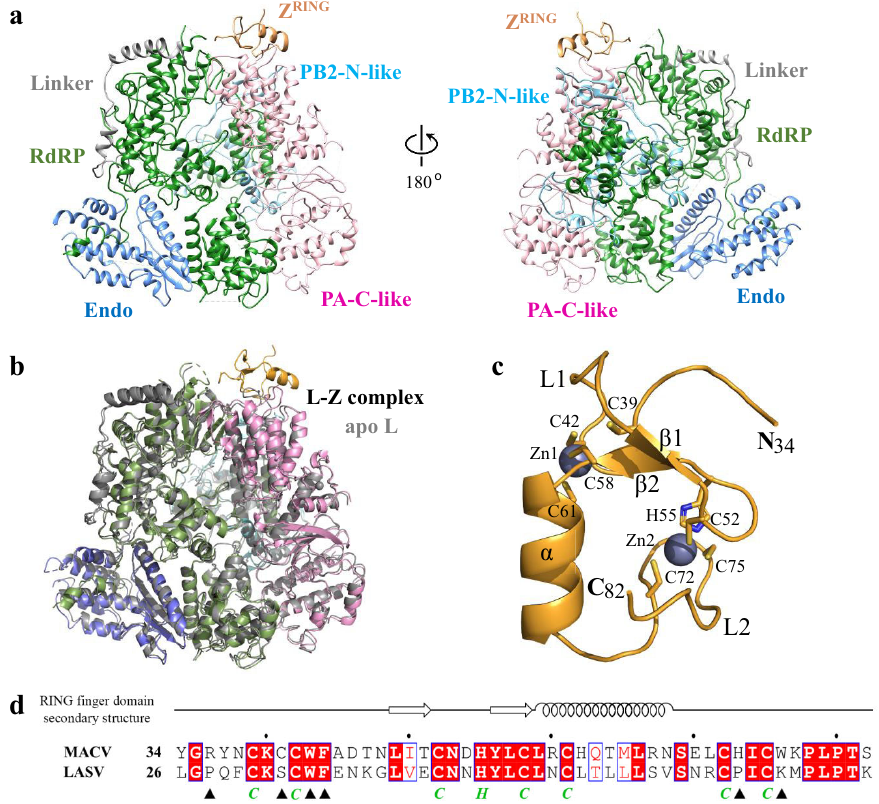
Fig. 2 Structure of the MACV L – Z complex. a Atom model of the L – Z complex shown as ribbon in two orientations. The domains are indicated and colored as in Fig. 1a. b Superposition of MACV L in the states of apo (colored gray) and Z-bound monomer (colored as Fig. 1a). c Structure of Z in the L – Z complex shown as ribbon and colored orange, with two divalent zinc atom shown as gray spheres. Side chains of conserved cysteines and histidine involved in Zn binding are shown as sticks and labeled. Although full-length MBP-Z fusion protein is used for structural study, only residues 34 – 82 are visible in the complex. d Sequence alignment for RING domain between the MACV and LASV Z proteins. Residues involved in the interaction with the L protein are marked below with black solid triangle, while conserved cysteines and histidine involved in Zn binding are marked below with green italicized C or H. Secondary structural elements are depicted on the top of the